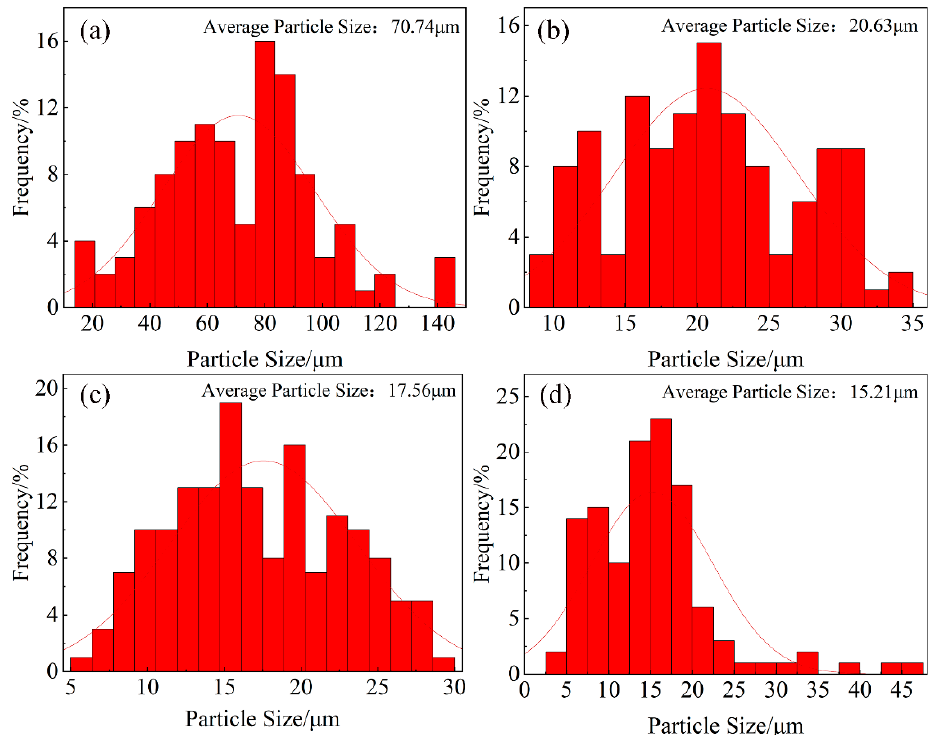
Figure 3. Size distributions of the primary Mg 2 Si phases in the alloys and the composites, ( a ) M-AC, ( b ) 1-COM, ( c ) 3-COM, and ( d ) 5-COM.